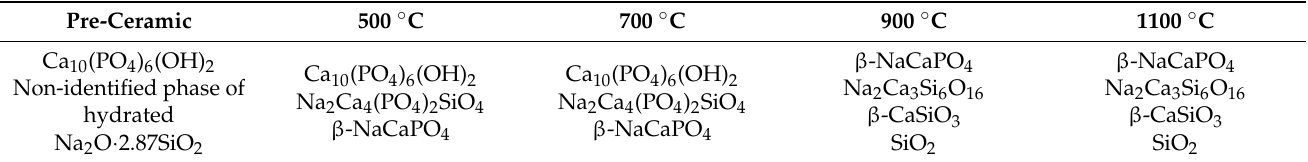
Table 1. Phase composition of pre-ceramic and ceramic